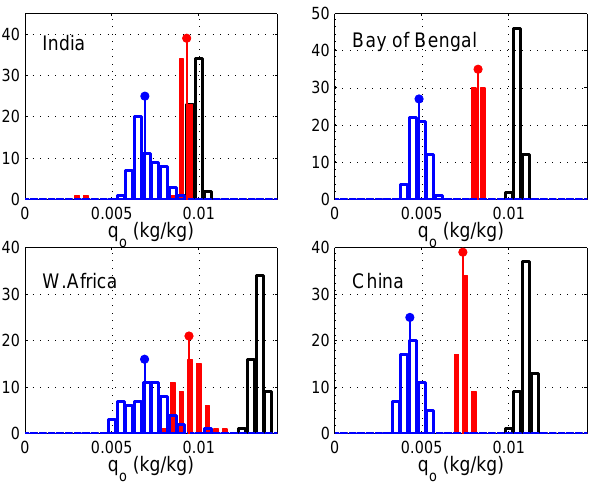
Fig. 10. Grey: Speleothem δ 18 O record from central China, used as EASM proxy for the penultimate glacial period, where more negative values indicate stronger rainfall (Wang et al., 2008). The record is smoothed with a 5-point running average, and dating errors L ( ± 2 σ ) are shown for selected dates (grey horizontal bars). Red: Re- sult of the conceptual model for EASM precipitation P in response to q o variations driven by northern hemisphere (65 ◦ N) summer in- solation, assuming a hysteresis of 0.5gkg − 1 width. For illustration, we set P to zero during periods when no monsoon circulation exists according to the